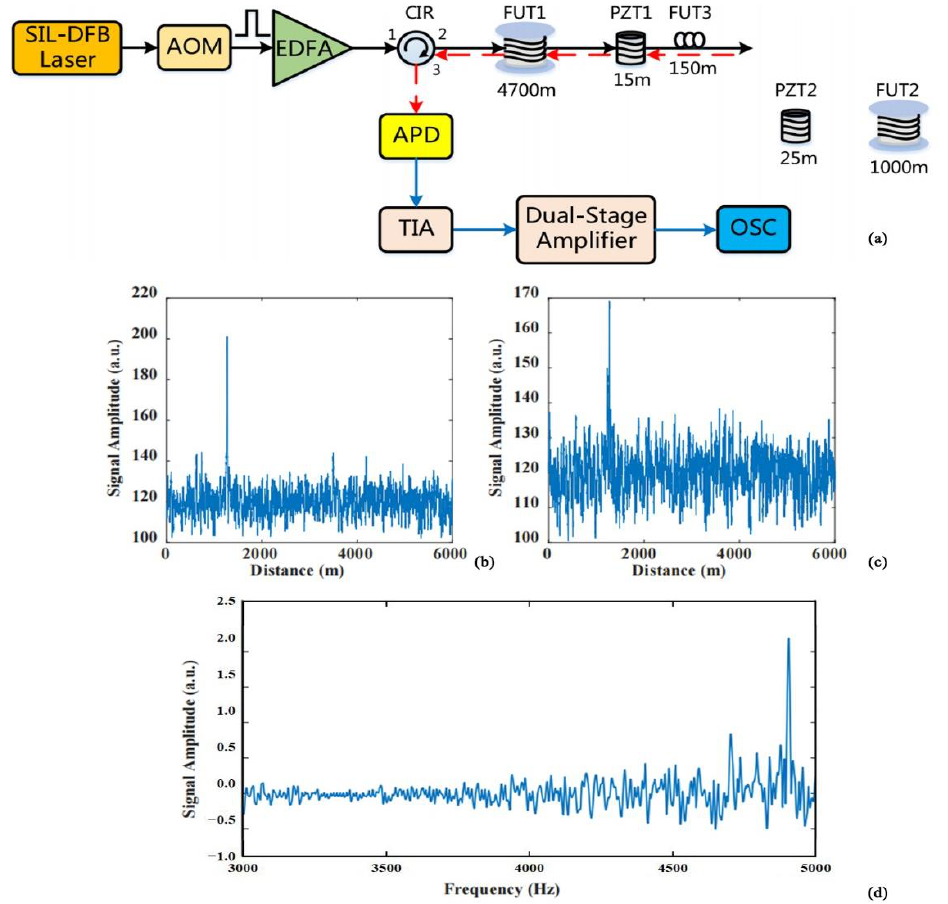
Figure 10. ( a ) Experimental setup. Localization of vibration sources at different frequencies: ( b ) 8 Hz; ( c ) 4.9 kHz. ( d ) FFT frequency spectrum at the 4.9-kHz vibration point [49].